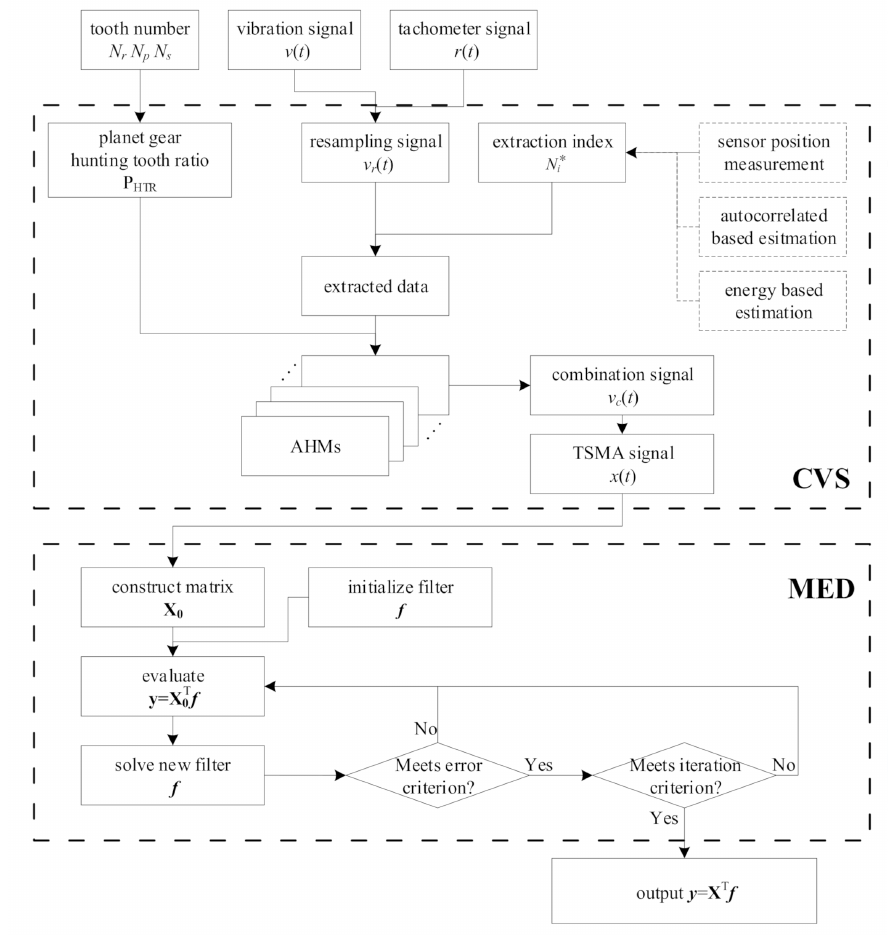
Figure 9. Fault diagnosis method for planet